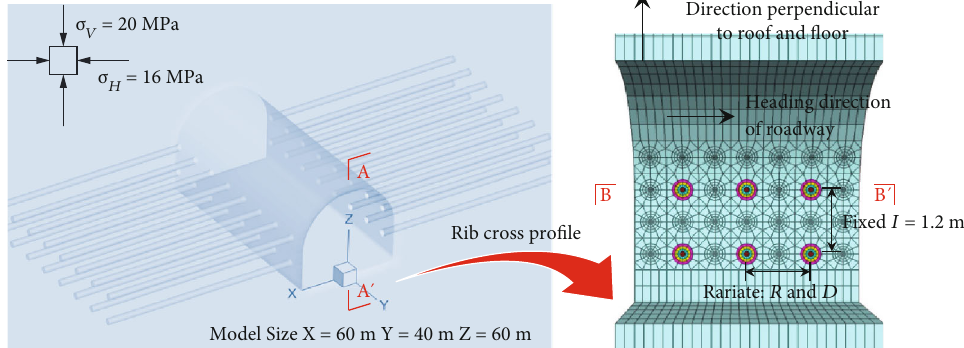
Figure 5: Numerical model containing depressurizing boreholes in FLAC 3D . (a) Illustrates the cross section of one rib along the longitude direction of roadway. The distance between the neighboring boreholes in the heading direction of roadway was de fi ned as row spacing R , while that in the direction perpendicular to the roof and fl oor was termed as interspacing I . The interspacing I was fi xed as 1.2m, while D and R were chosen as the variables in this study. D and R will be constructed according to the design schemes. Table 2: Simulation schemes for the depressurizing boreholes.